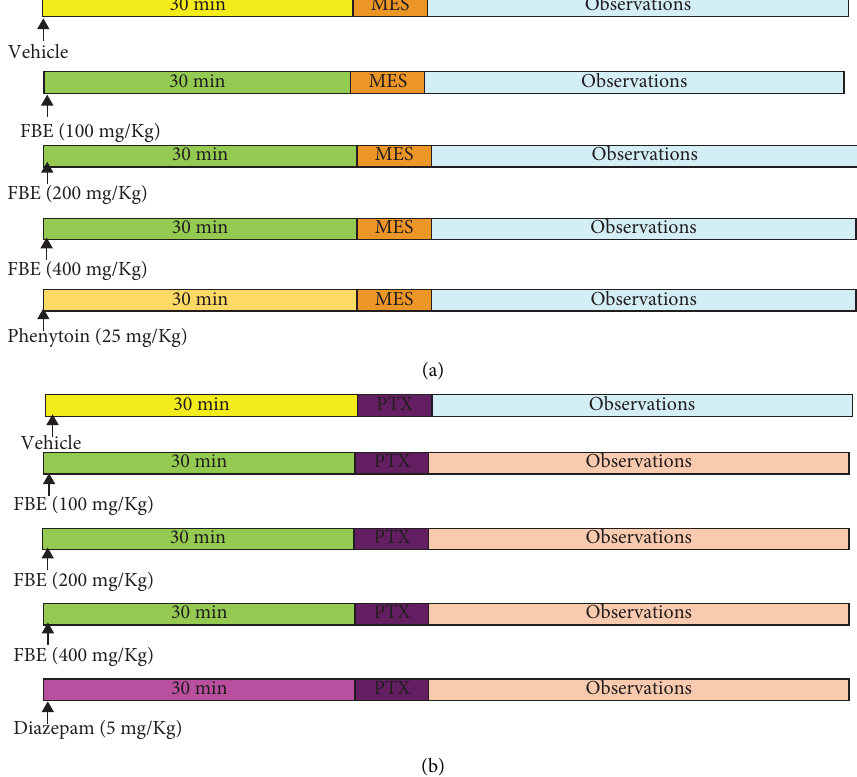
Figure 1: Schematic protocols for anticonvulsant activity of Ficus benjamina L. in (a) maximal electroshock-induced convulsions and (b) picrotoxin-induced convulsions in mice.